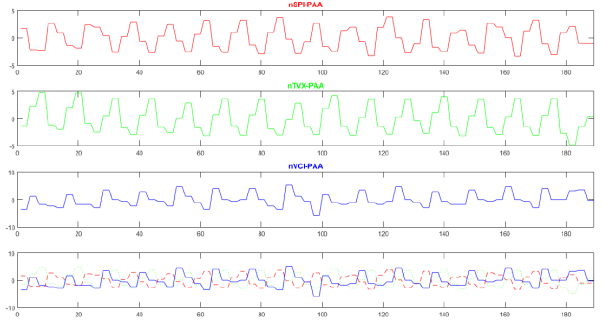
Figure 4: PAA presentation for drought index